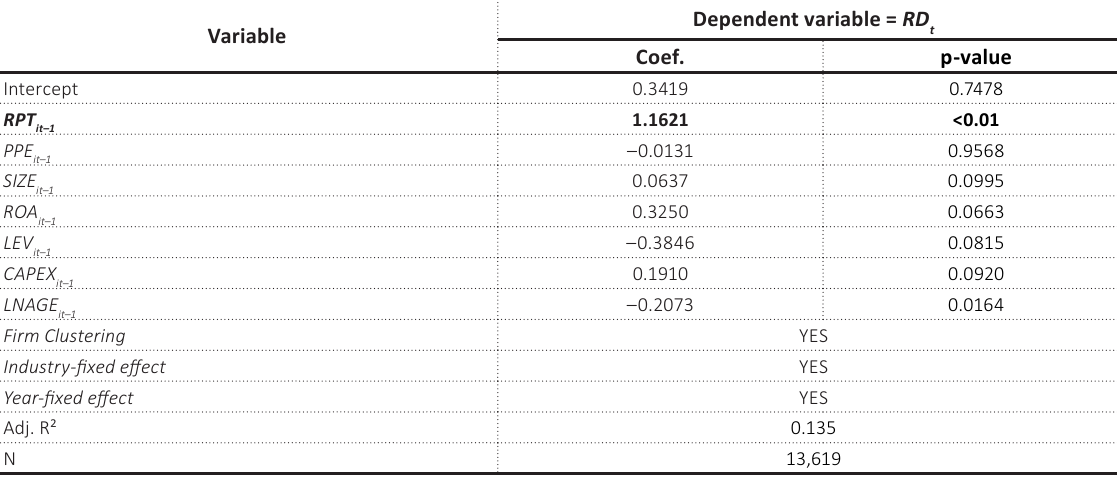
Table 3. Relate party transactions and firm R&D investments Panel A: Effect of RPTs on firm’s R&D